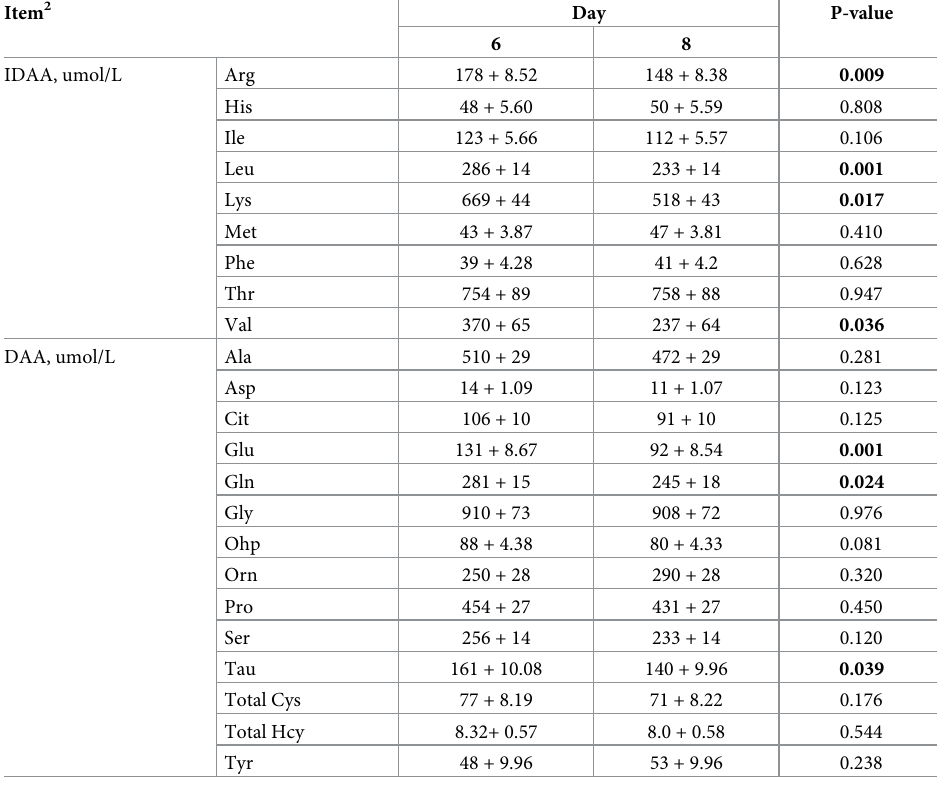
Table 4. The effect of sampling time (day 6 vs. day 8) on plasma amino acid concentrations (lsmeans + SEM 1